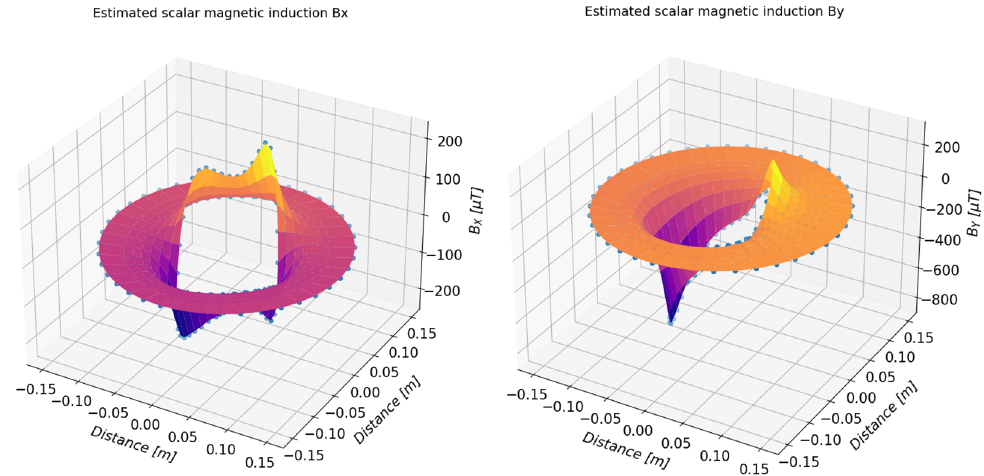
Figure 25. The three-dimensional view of the estimated value of the B x ( left ) and B y ( right ) compo- nents of the magnetic induction of the examined magnets determined on the basis of the measure- ments.